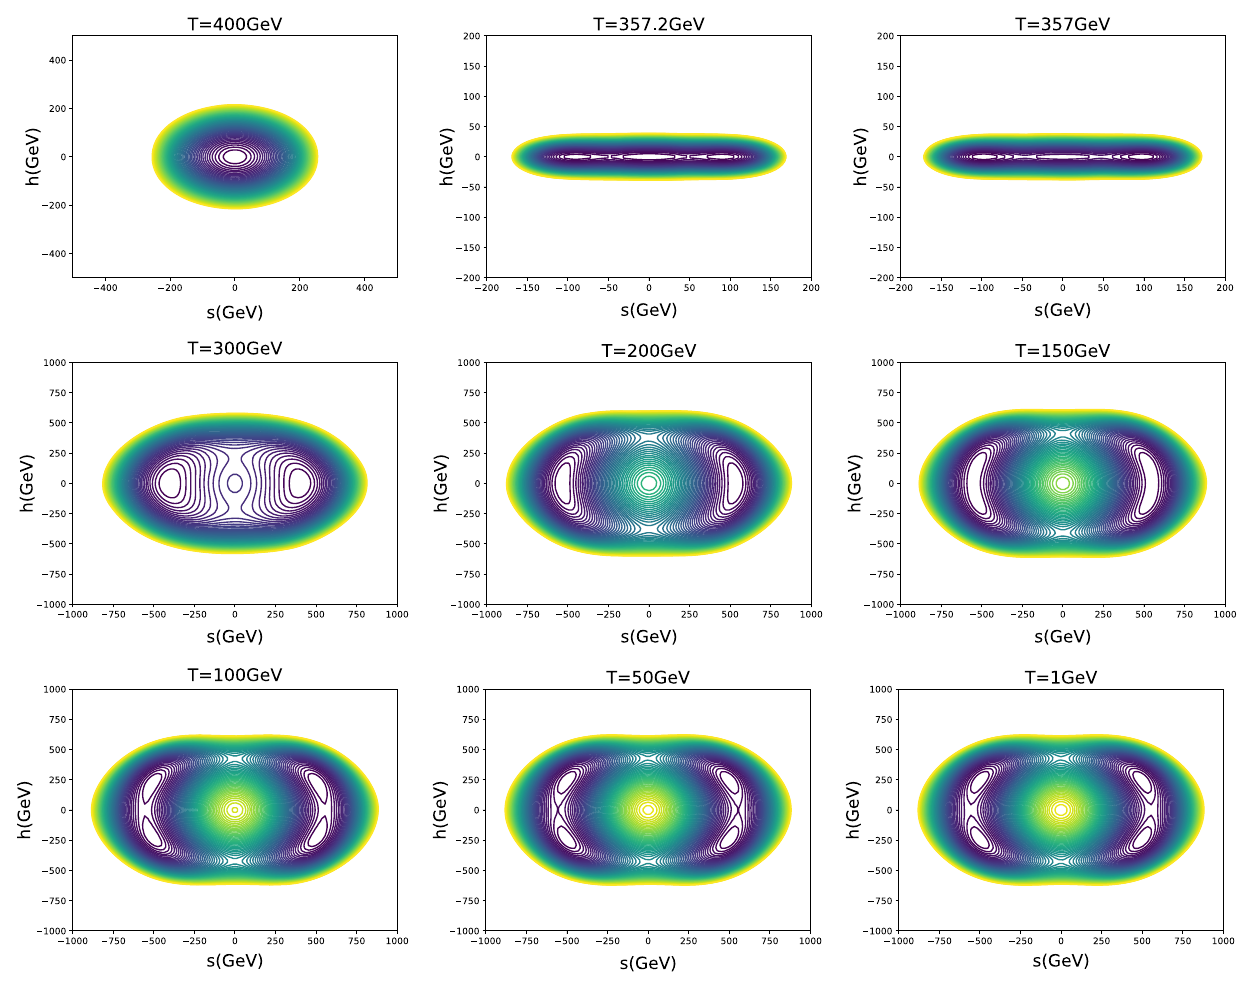
= 0 . 2028, g = 1 . 75. Here the s -direction PT happens at the λ sh temperature T (cid:4) 357 . 08 GeV, the higher-order PT happens around T (cid:4) 162